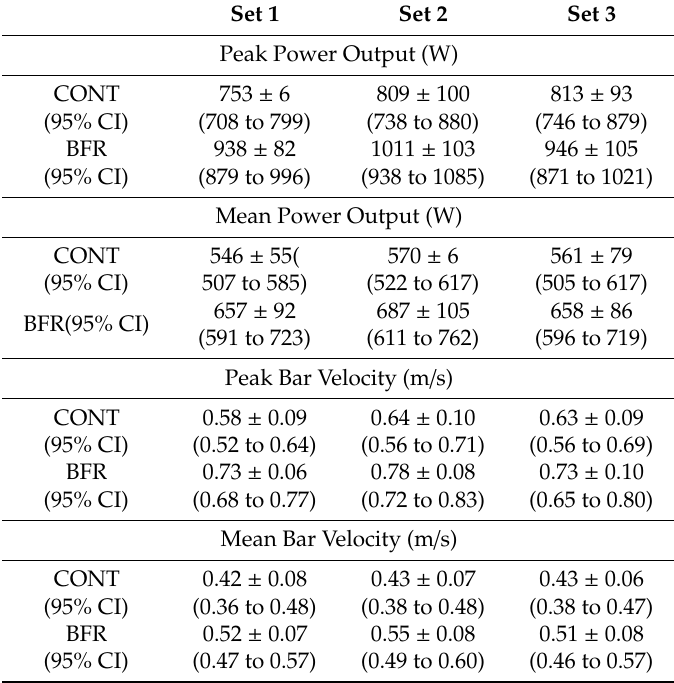
Table 1. Power output and bar velocity in 3 successive sets of the bench press exercise under CONT and BFR conditions.